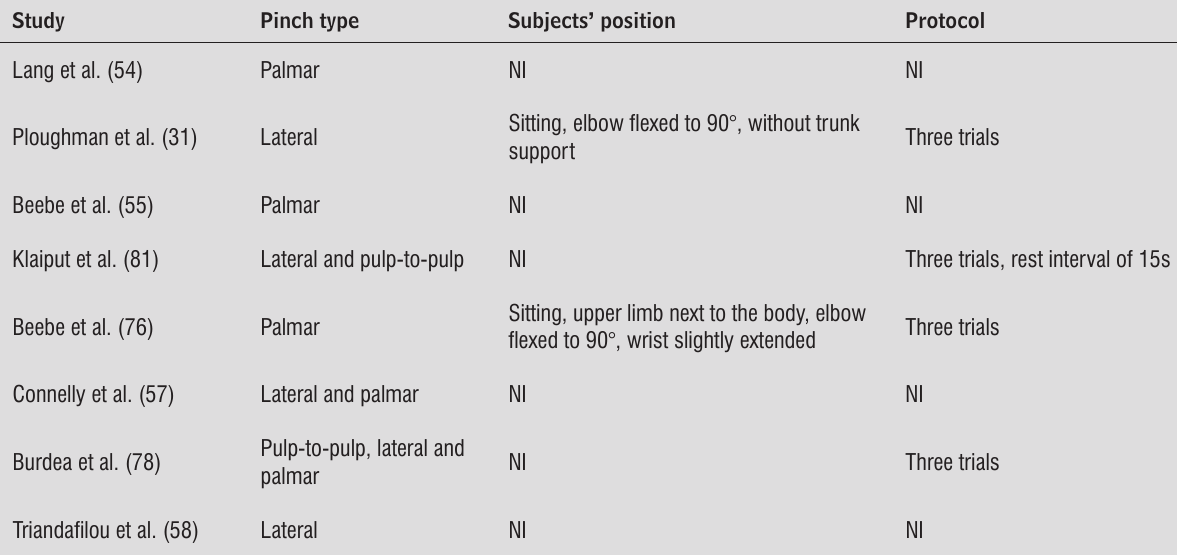
Table 3 - Data extraction of the 15 studies which assessed pinch strength in subjects with stroke with portable